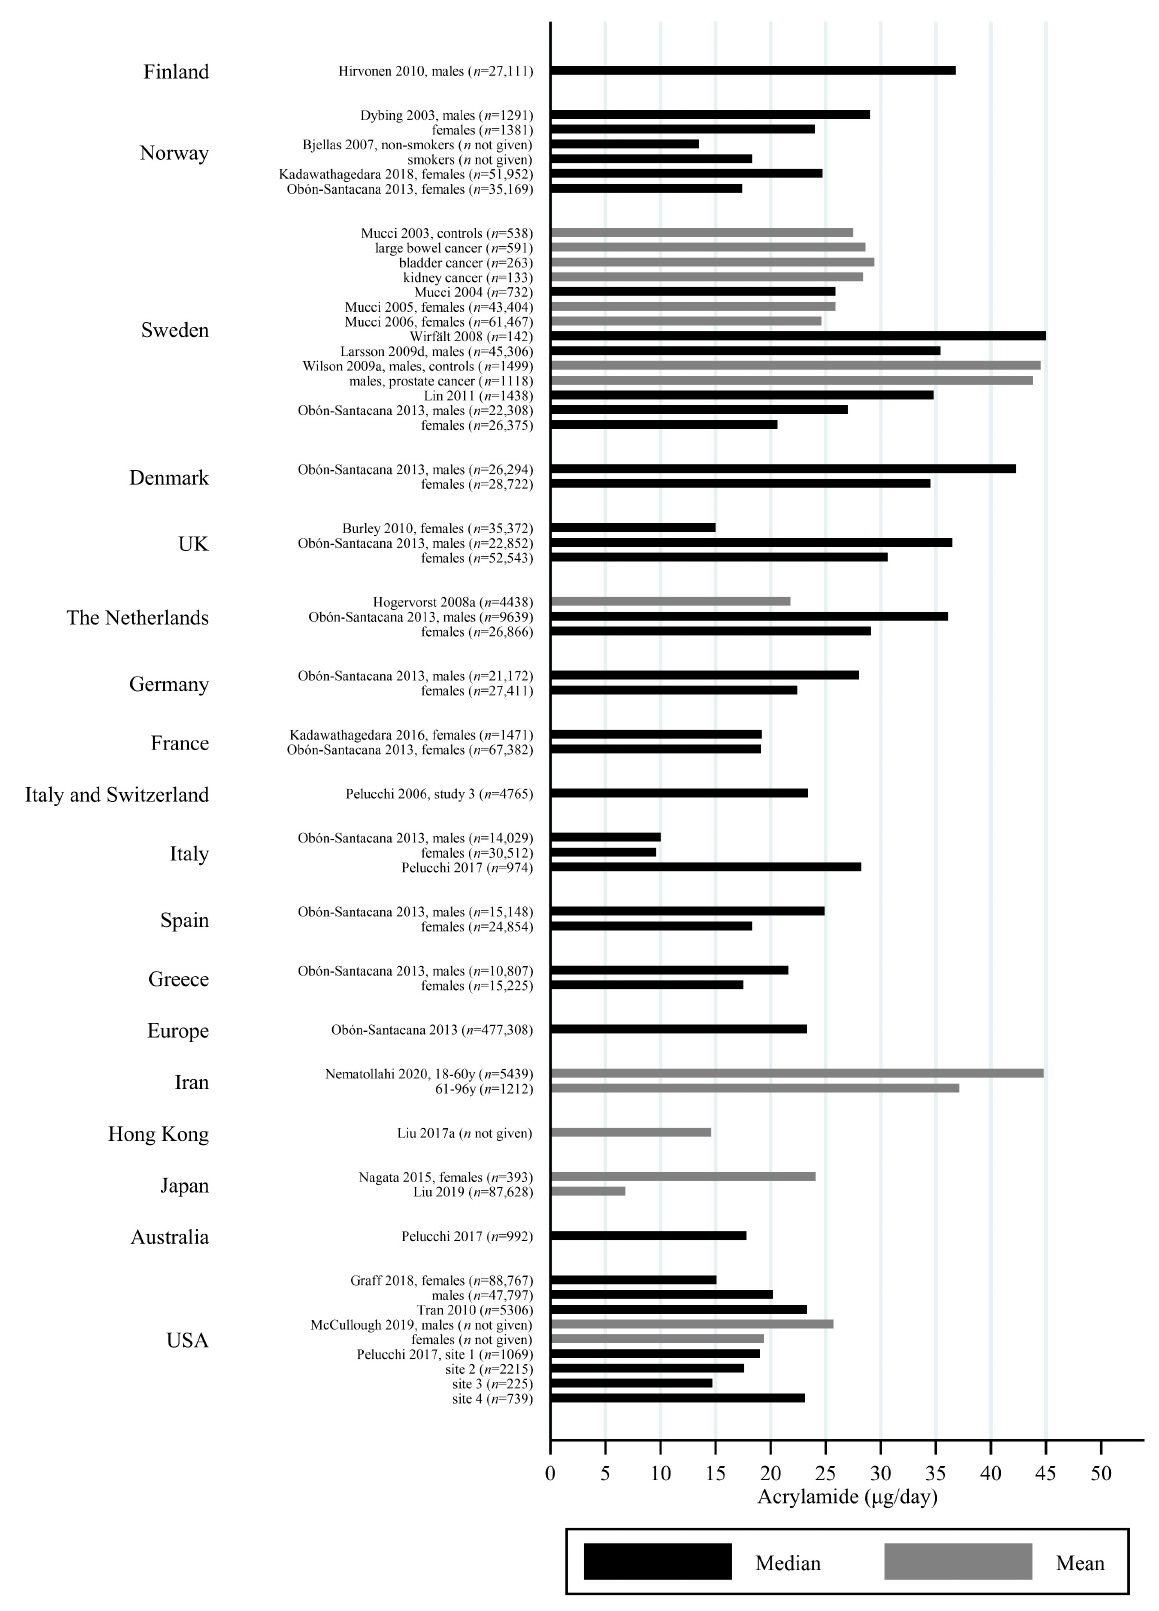
Figure 4. Median/mean estimated daily acrylamide intake ( µ g/day), based on dietary questionnaire or both dietary questionnaire and dietary recall, by